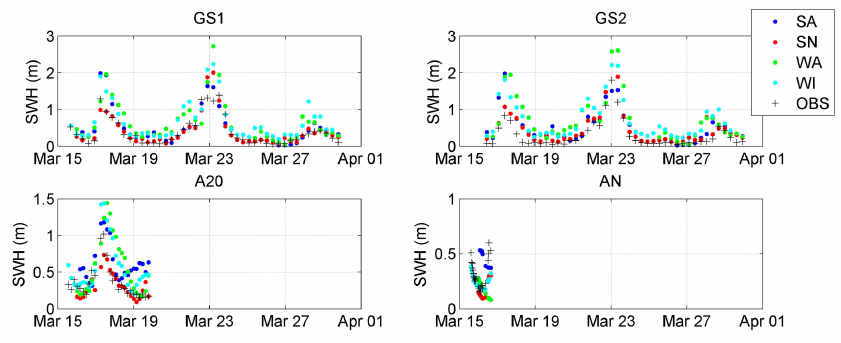
Fig. 4. Data at the survey stations and interpolated models outputs during DART06A.